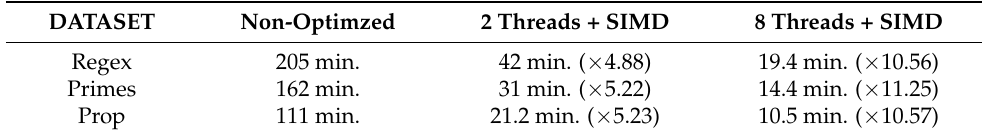
Table 2. Comparison between